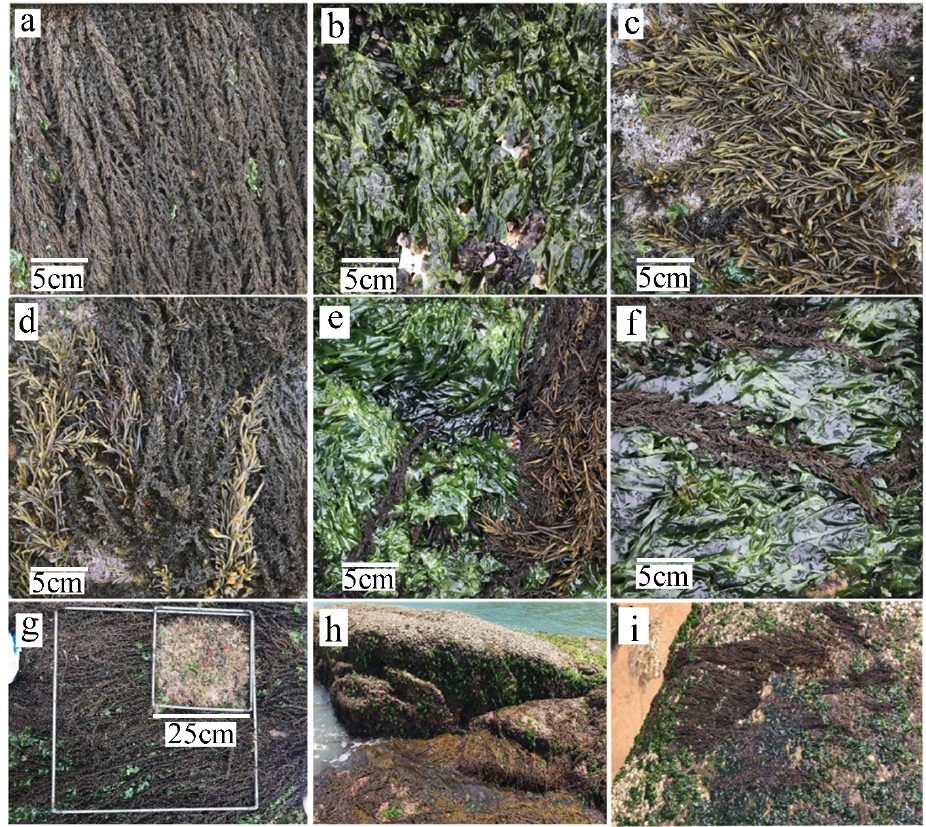
Figure 4. Seaweed photos. ( a – c ) are Sargassum thunbergii , Ulva pertusa , and Hizikia fusifarme , respec- tively; ( a – f ) are photographs used for analysis (clipping of quadrat), ( g ) is after sampling, ( h , i ) are field photographs.